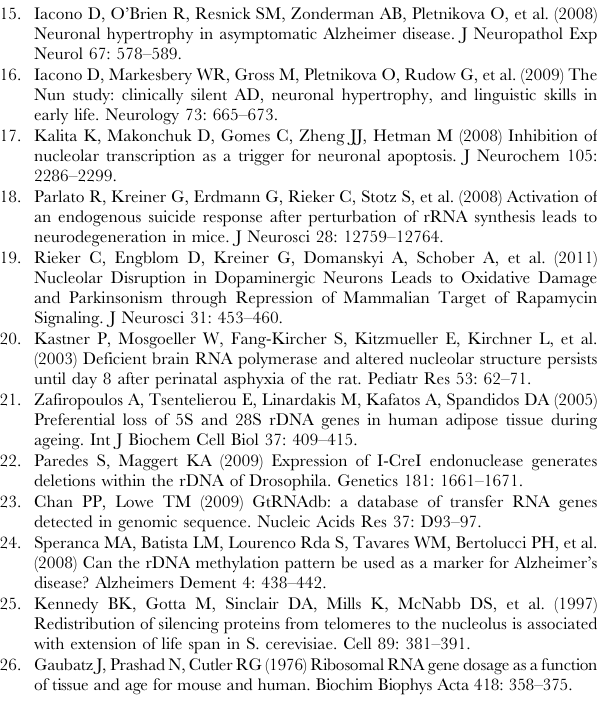
the actual mean difference values; the black solid line represents a smoothed regression fit of those values across the rDNA promoter region; the green lines indicate the border of the 95% confidence range for the actual values (dashed line) or the smoothed regression (solid line). For more details, see description of Figs. 3– 4. (TIF) Figure S5 Effects of MCI and AD on 18S-, 5.8S- and 28S rRNA levels. Quantitative real time PCR analysis of rRNAs was performed using the standard curve method. A–C , In parietal cortex, MCI or AD did not affect 18S-, 5.8S-, or 28S rRNA levels. D–F , In prefrontal cortex an AD- associated decrease of 28S-, but not, 18S-, or 5.8S rRNA was observed. Individual values are depicted by squares; mean values are indicated by the horizontal bars that intersect the error bars (SEM); p values are shown; n = 10 or 15 for each group in A–C or D–F, respectively. (TIF) Table S1 Primers and PCR conditions. (DOC) Methods S1 A text file containing detailed description of the modified SAM